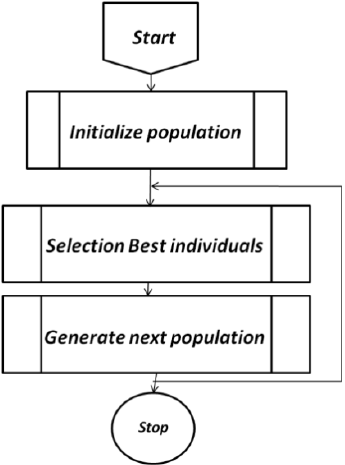
Figure 3. Basic flow chart of a genetic algorithm.